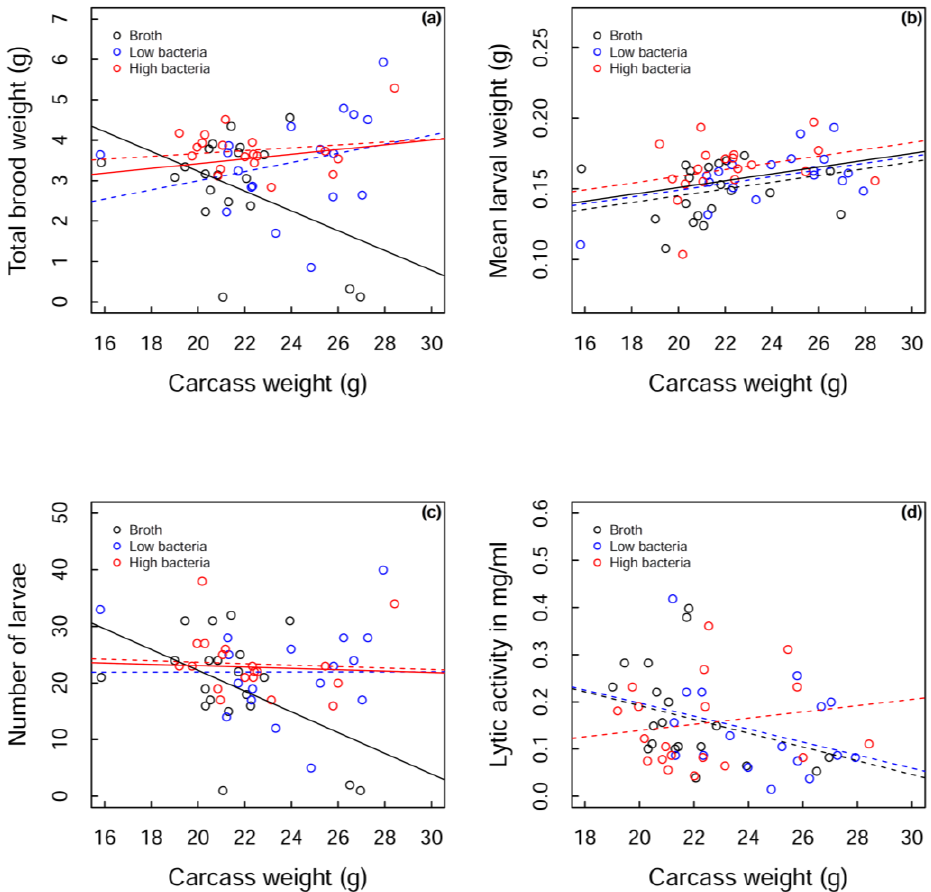
Figure 3. Measurements of three reproductive outputs, ( a ) total brood weight; ( b ) mean larval weight and ( c ) number of larvae produced; as well as ( d ) lytic activity against carcass weight for each of the three treatment groups: broth (black), low bacteria (blue) and high bacteria (red). Raw data is shown in open circles. Dotted lines show fitted values for each treatment group. The fitted values for the pooled bacterial treatment group are shown in solid red lines against solid black lines for the nutrient broth control group. A solid black line also shows the overall fitted values of the model in ( b)